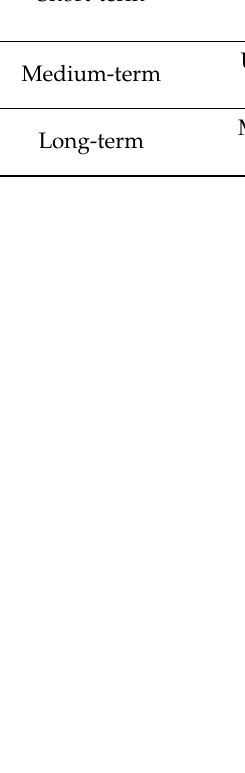
Table 2. Description of major factors affecting wind power